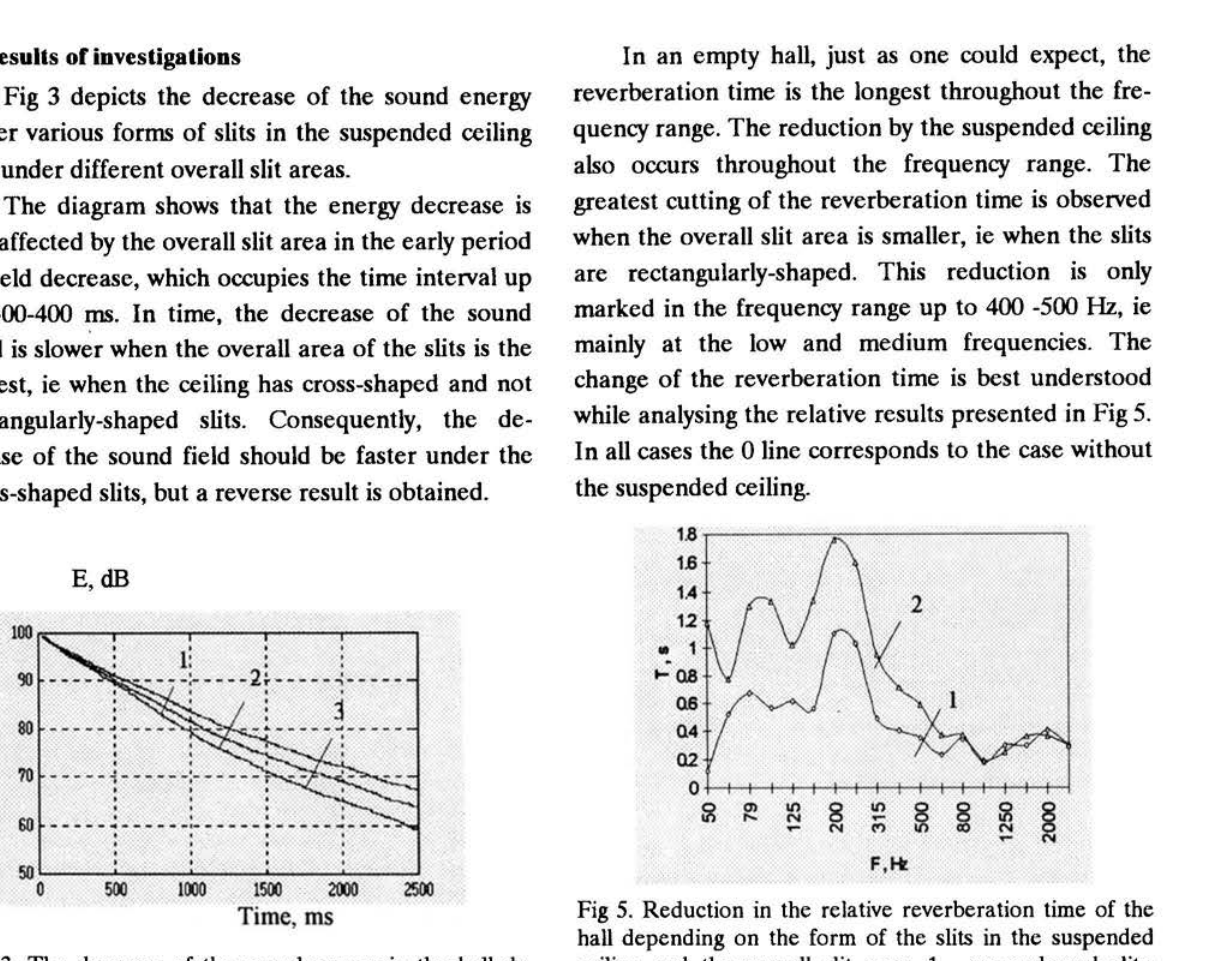
Fig 3. The decrease of the sound energy in the hall de pending on the form of the slits and the overall slit area. 1 - hall without suspended ceiling; 2 - with cross-shaped slits; 3 - with rectangularly-shaped slits